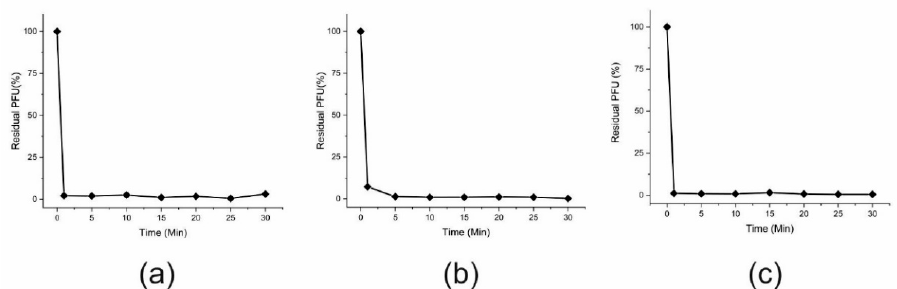
Figure 2. Adsorption curves of fEg-Aba01 ( a ), fLi-Aba02 ( b ), and fLi-Aba03 ( c ) to A. baumannii #6597. The phage titer in the control supernatant was set to 100% and the residual titers at different time points were related to that. Each assay was performed in duplicate and repeated for 3 times. Note that the standard deviation bars are mostly hidden behind the symbols.